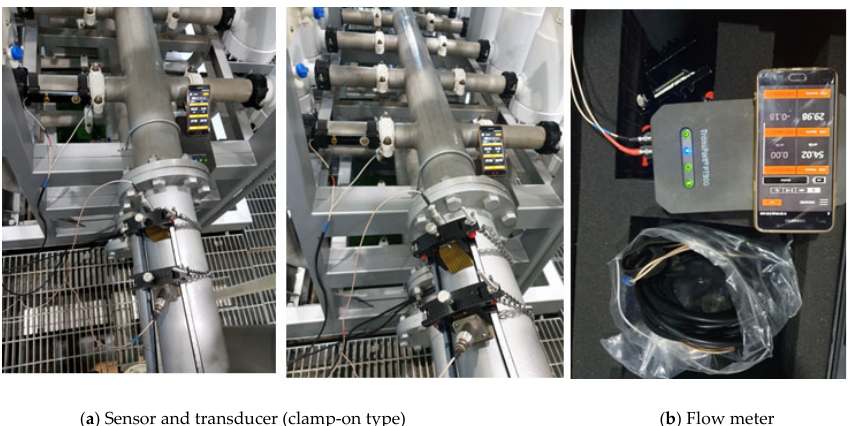
Figure 3. Clamp ‐ on transducer and ultrasonic liquid flow meter adopted in this research. ( a ) Sensor and transducer (clamp ‐ on type); ( b ) Flow meter.